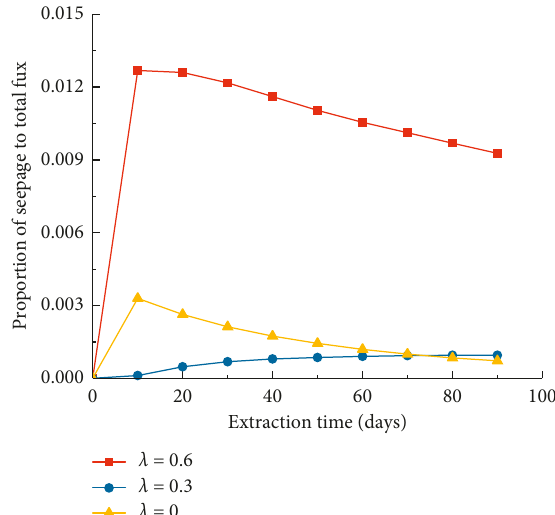
Figure 11: Evolution of proportion of matrix seepage flux to total flux from the matrix to fracture.